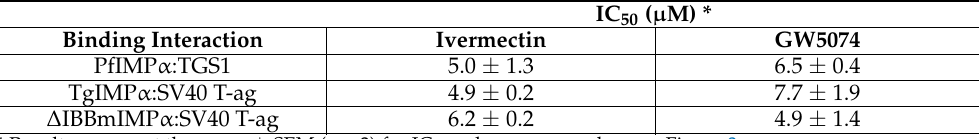
* Results represent the mean ± SEM (n = 3) for IC 50 values measured as per Figure